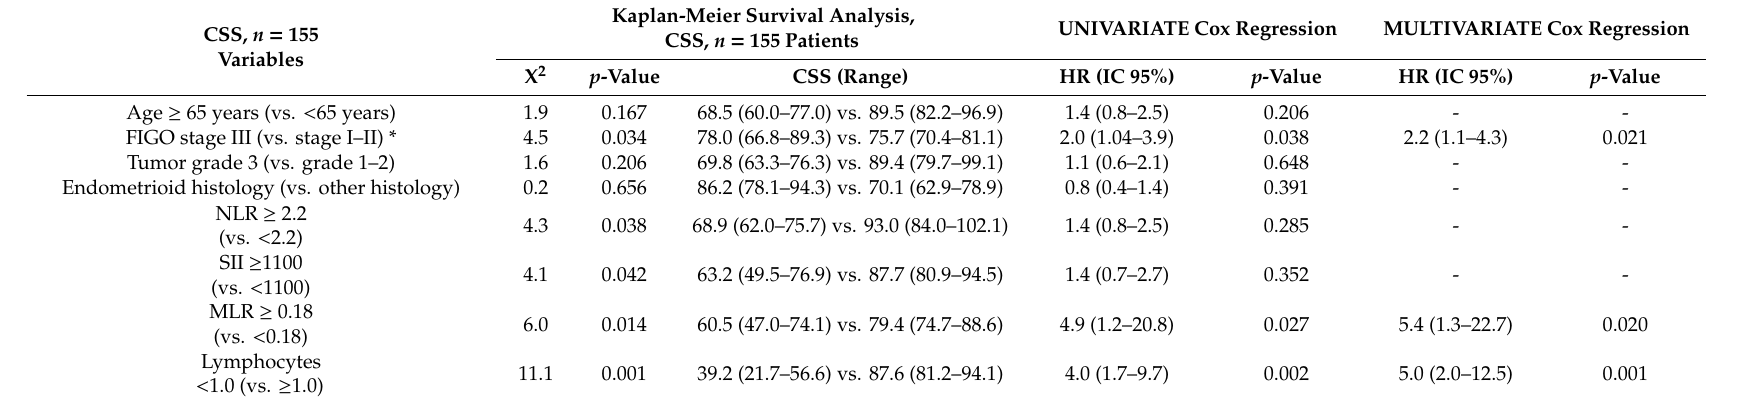
Table 2. Cancer-specific survival analysis ( n = 155).